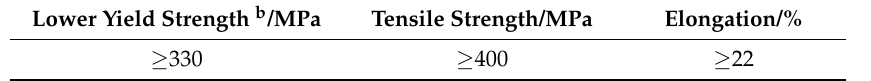
Table 2. Mechanical properties of hot rolled and high-strength pickling enamel steel BTC330R. Lower Yield Strength b /MPa Tensile Strength/MPa